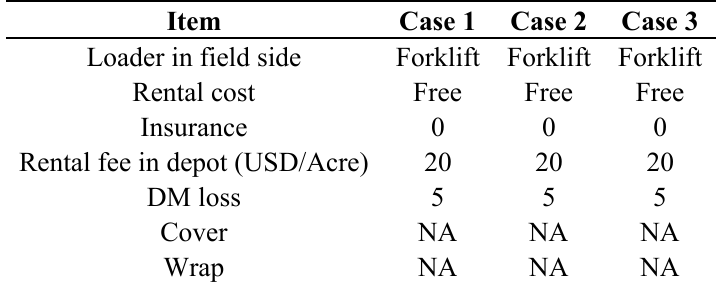
Table B3. Equipment and other elements used during storage.